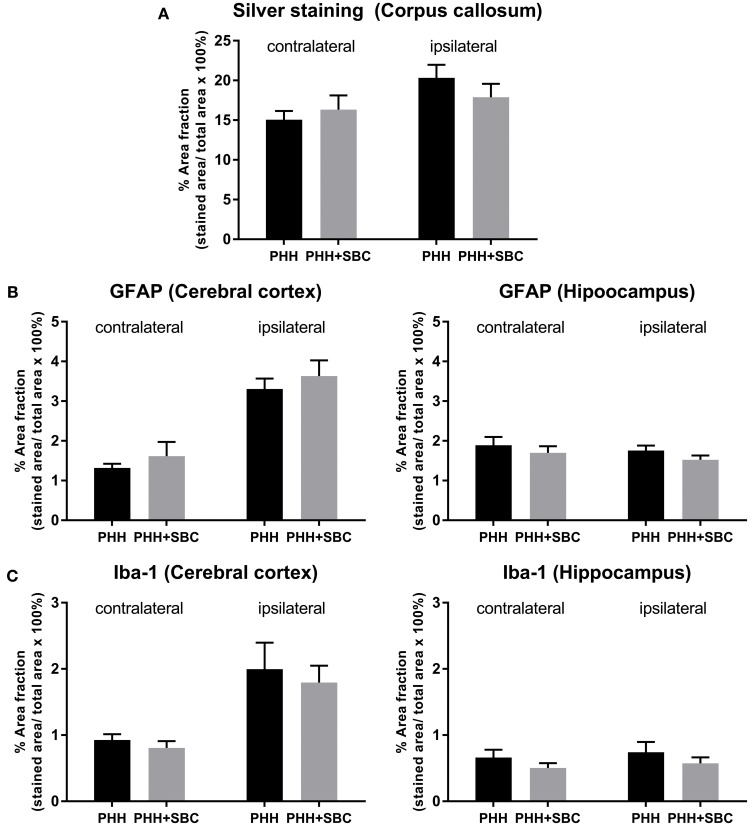
Quantification of neurodegeneration by silver staining in the corpus callosum (A), astrocytic activation by GFAP (B) and microglial activation by Iba-1 (C) in the cerebral cortex and hippocampus of both hemispheres. PHH group n = 13; PHH+SBC group n = 12. Student's t-test did not detect statistically significant differences between groups.